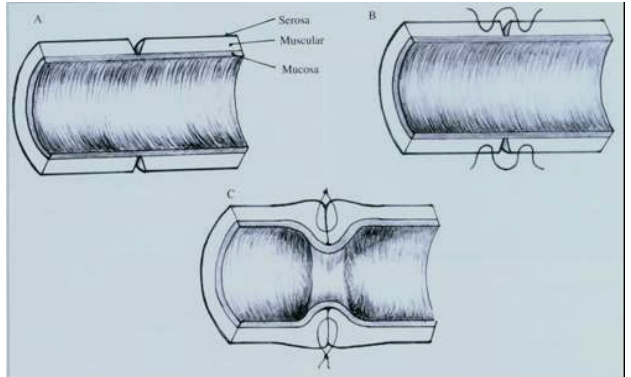
FIGURE 2 – Picture showing the extra-mucosal circunferencial seromyotomy procedure